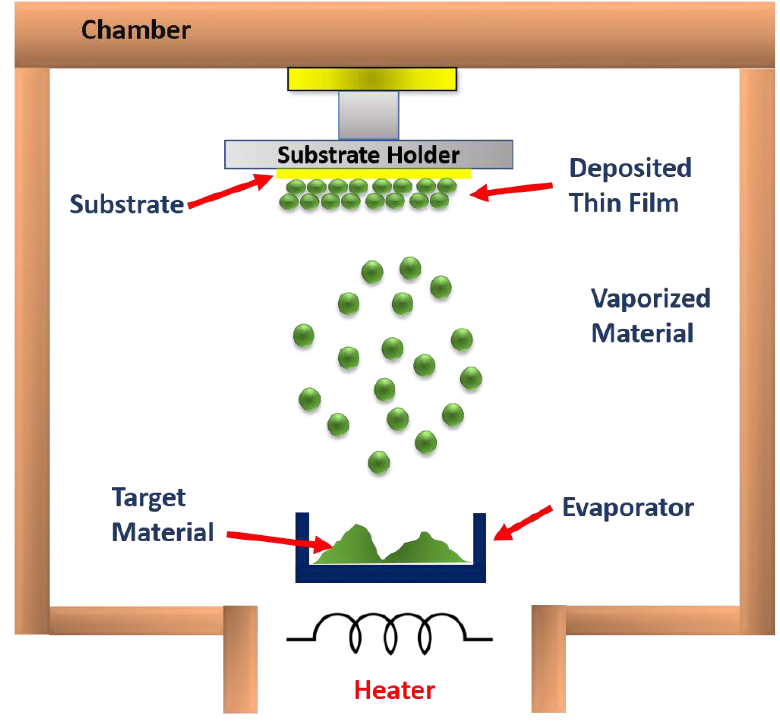
Figure 1. Schematic diagram of thermal evaporation.